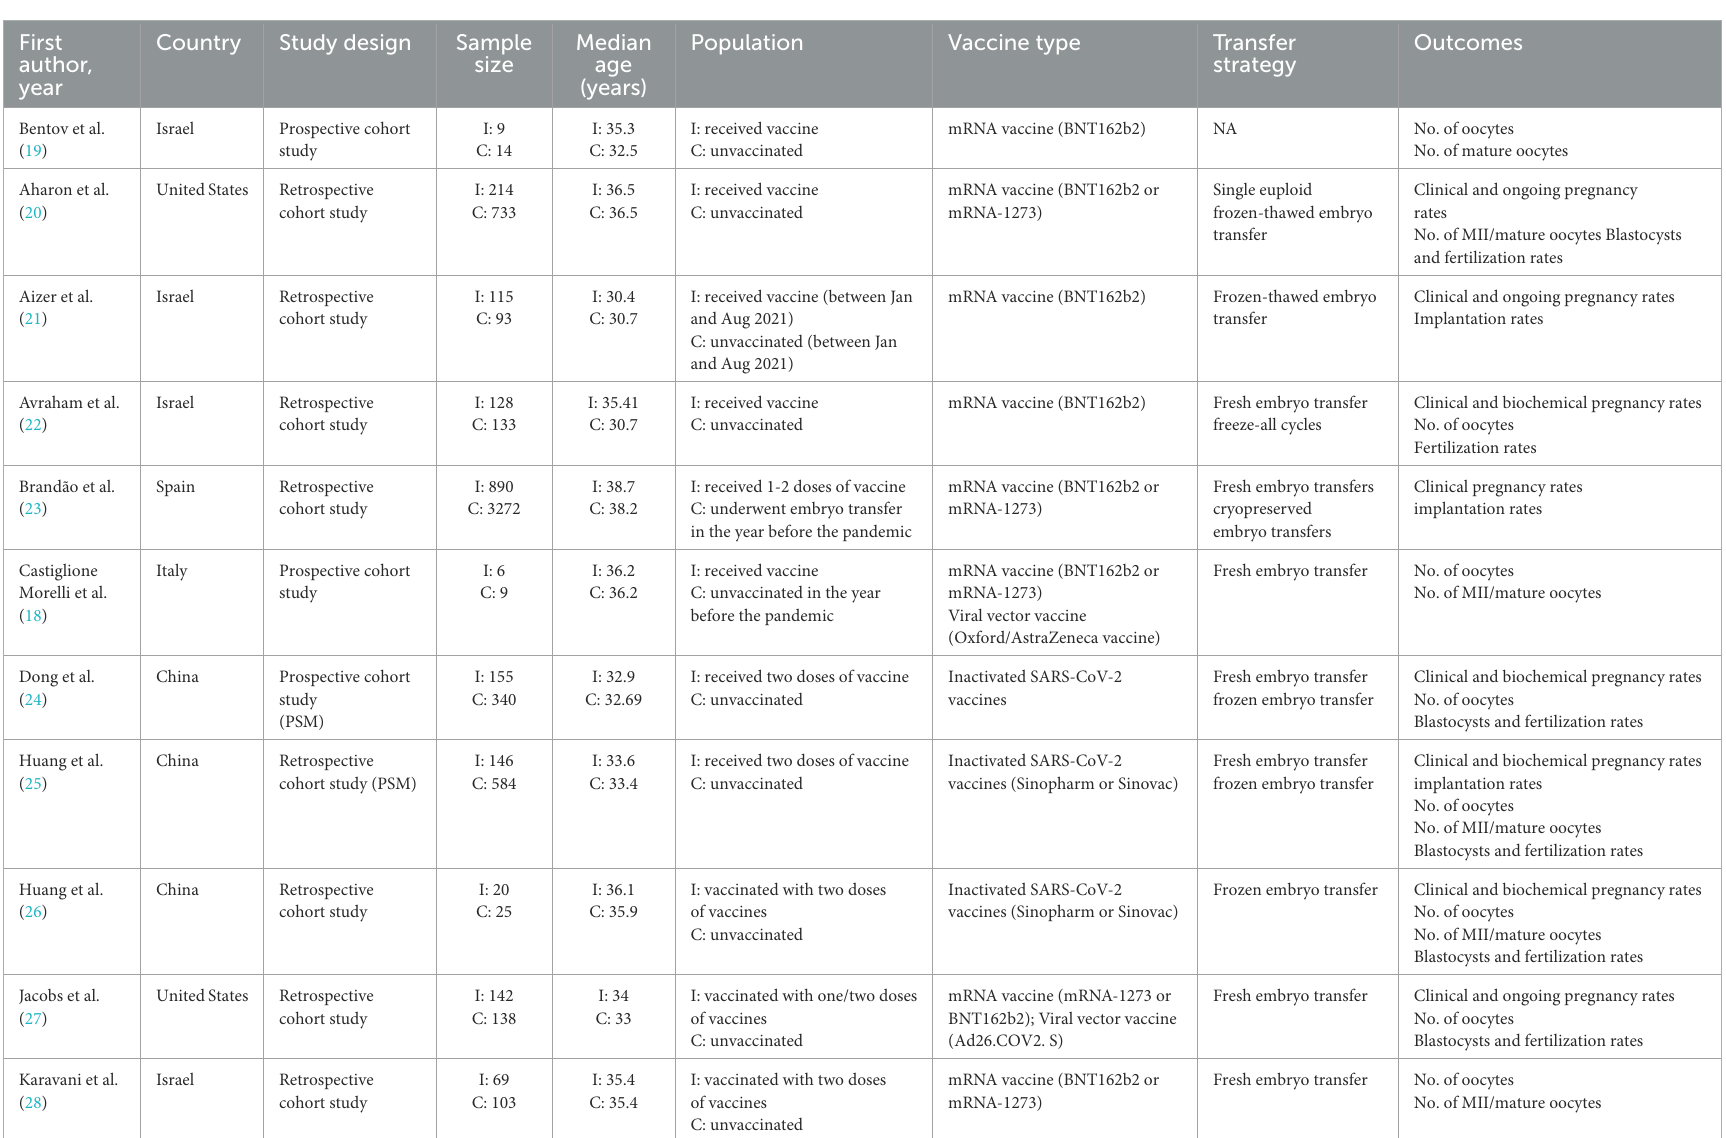
TABLE 1 Characteristics of studies included this systematic review and